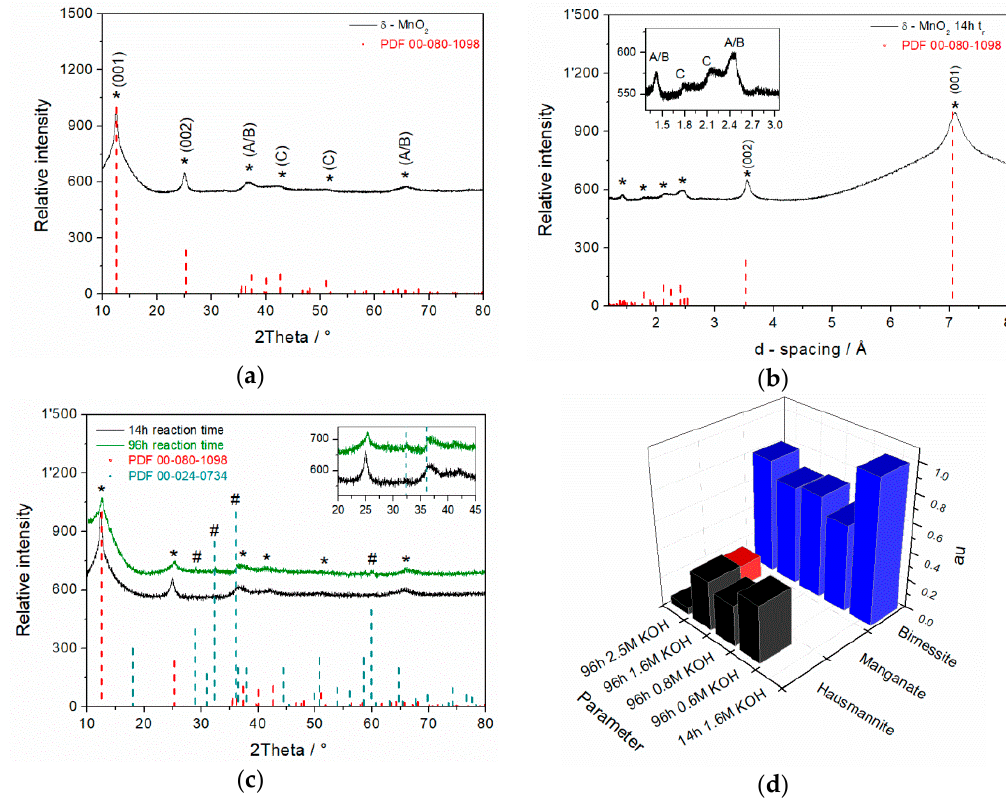
Figure 2. HR-XRD diffraction pattern of as prepared δ -MnO 2 after 14 h reaction time ( a , b ) where, A & B indexes in inlet are related to monoclinic & turbostratic and C to hexagonal crystal system, respectively. Comparative diffraction patterns of MnO 2 after 96 h and 14 h reaction time ( c ). K- birnessite (PDF 00-080-1098 *) and hausmannite (PDF 00-024-0734 #) are shown as references. Qualitiative evaluation of MO species in dependence on hydroxide concentration and reaction time from (001) and (002) reflexes ( d ).